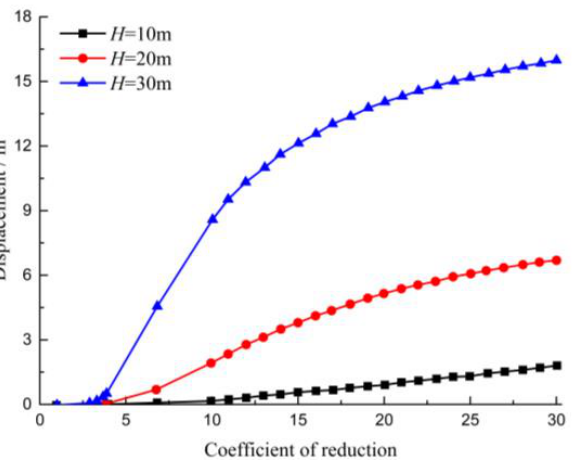
Figure 13. Variation curve of ridge vertex displacement with reduction coefficient under different H.